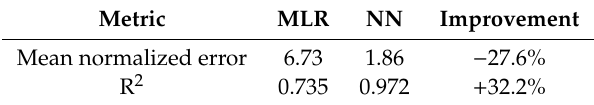
Figure 11. The training results and prediction results by the NN and MLR; ( a ) Neural network results; ( b ) Multi linear regression. Table 7. Neural network prediction model performance comparing with MLR